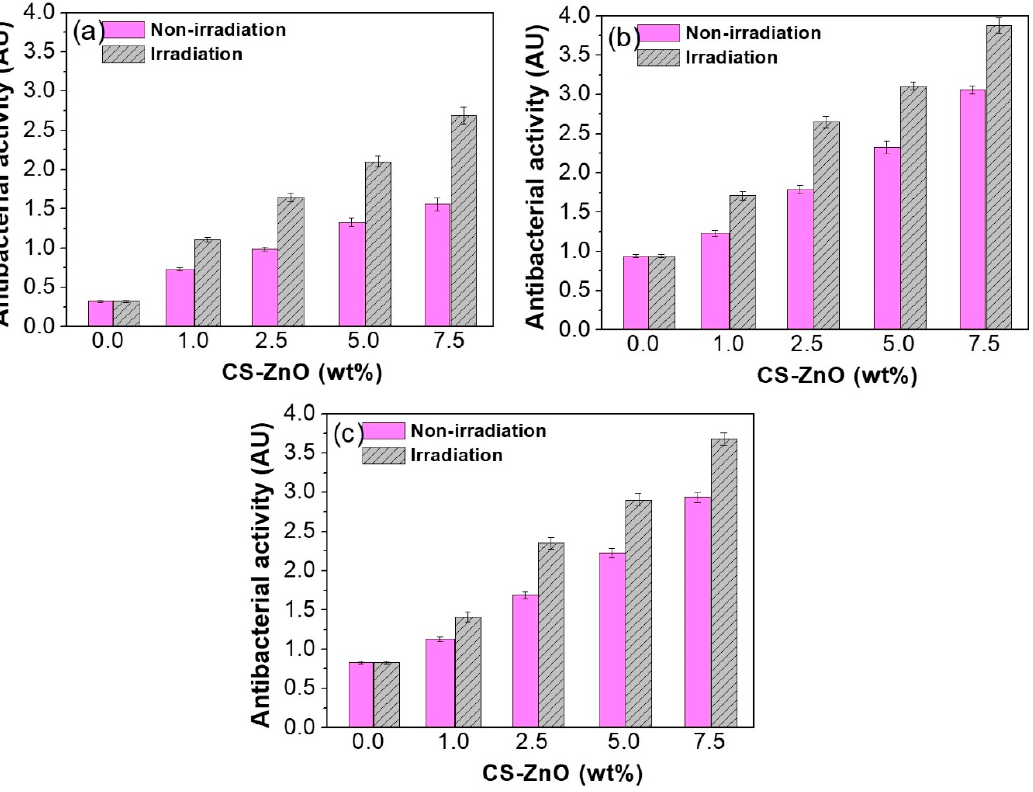
Figure 9. Antibacterial activity of CO/CS-ZnO nanocomposites versus ( a ) E. coli , ( b ) S. aureus , and ( c ) M. luteus . Solid and dashed bars correspond to experiments performed without and with UV light irradiation, respectively. Reprinted from [18], copyright 2015, with permission from the American Chemical Society.